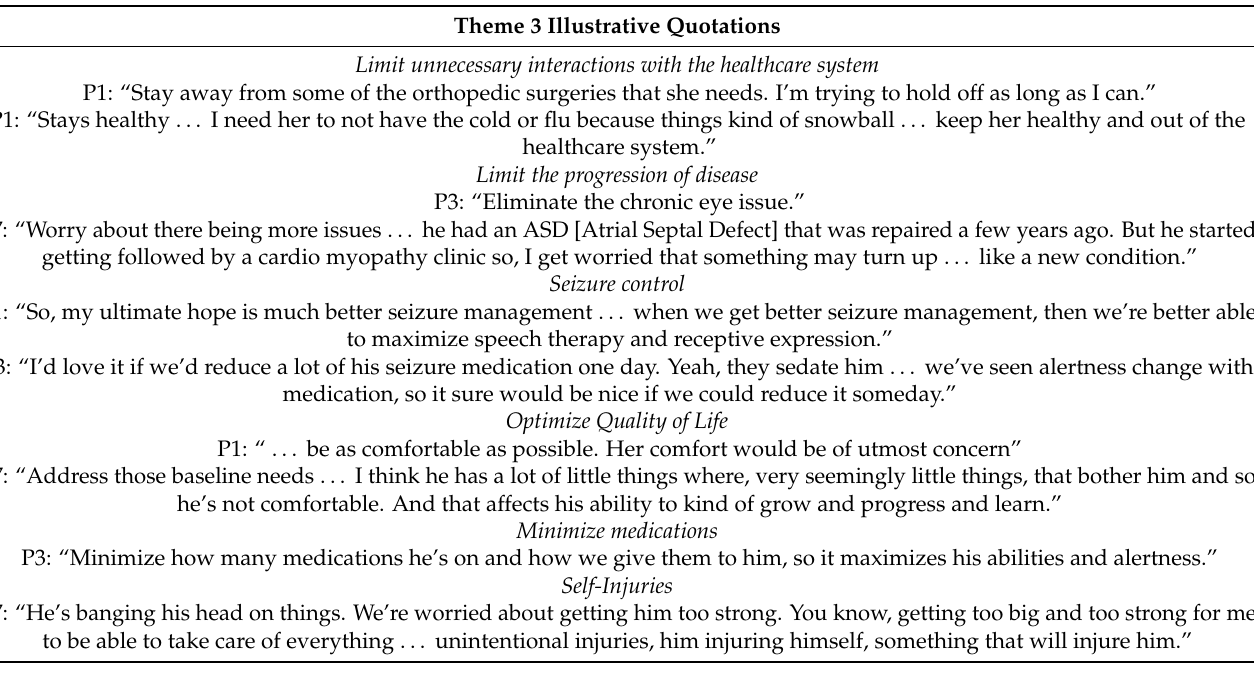
Table 4. Theme 3 Managing Symptoms and Disease